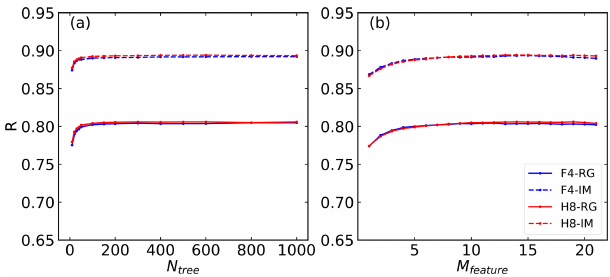
Figure 3. Dependence of the correlation coefficient ( R ) on the pa- rameters N tree (a) and M feature (b) .